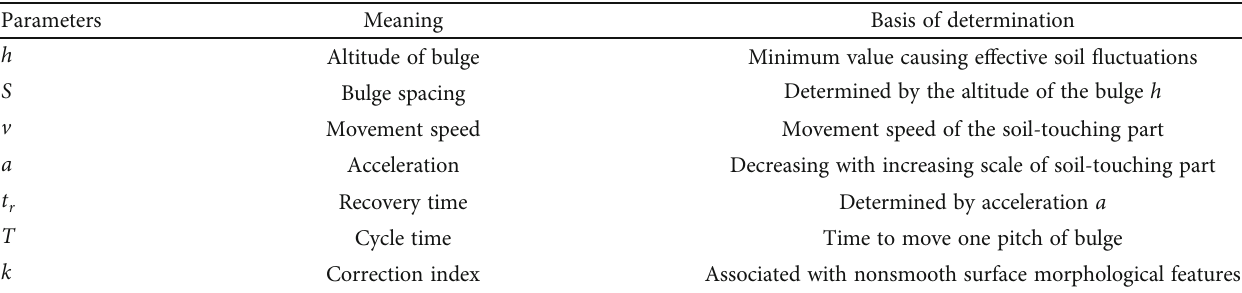
Figure 7: Schematic diagram of the individual soil particle movement. Table 1: Meaning and basis for determining the parameters.